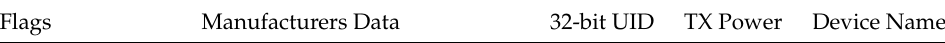
Table 2. Detailed BLE beacon advertisement